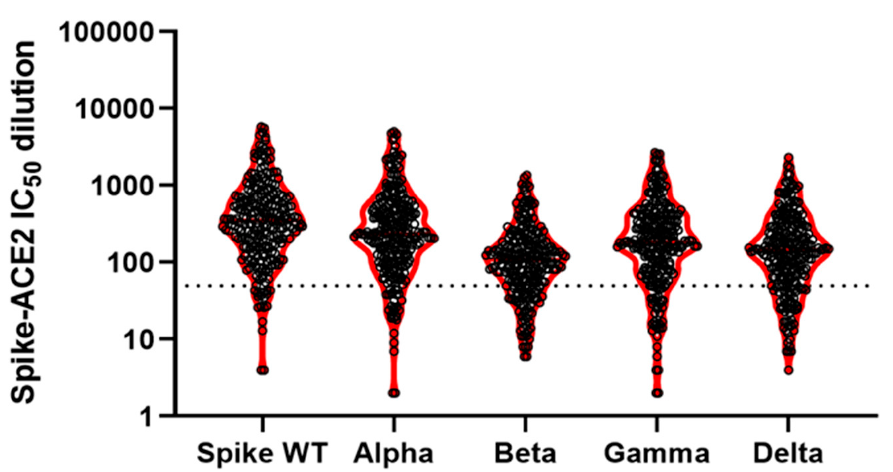
Figure 5. SARS-CoV-2 antibodies’ neutralizing activity by variant in the sub-sample of seropositive participants at the third serosurvey in June–July 2021 (N = 250).